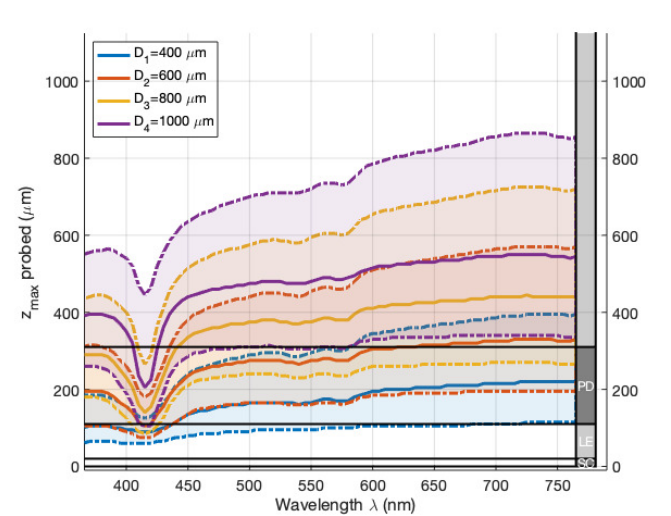
Figure 5. Maximal probed depth values of detected photons in the healthy skin model with interme- diate thicknesses of SC and LE layers and mean dermal blood content, as a function of wavelength and SD distances. Solid and dashed-dot lines represent median and quartiles values, respectively. The right column and the black horizontal lines illustrate the position of the border between the layers (SC: stratum corneum; LE: living epidermis; PD: papillary dermis; RD: reticular dermis; SF: subcutaneous fat (not represented